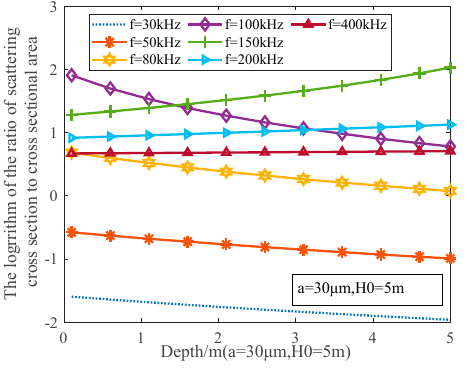
Figure 1. Scattering Ability of Wake Bubbles at Different Frequencies.